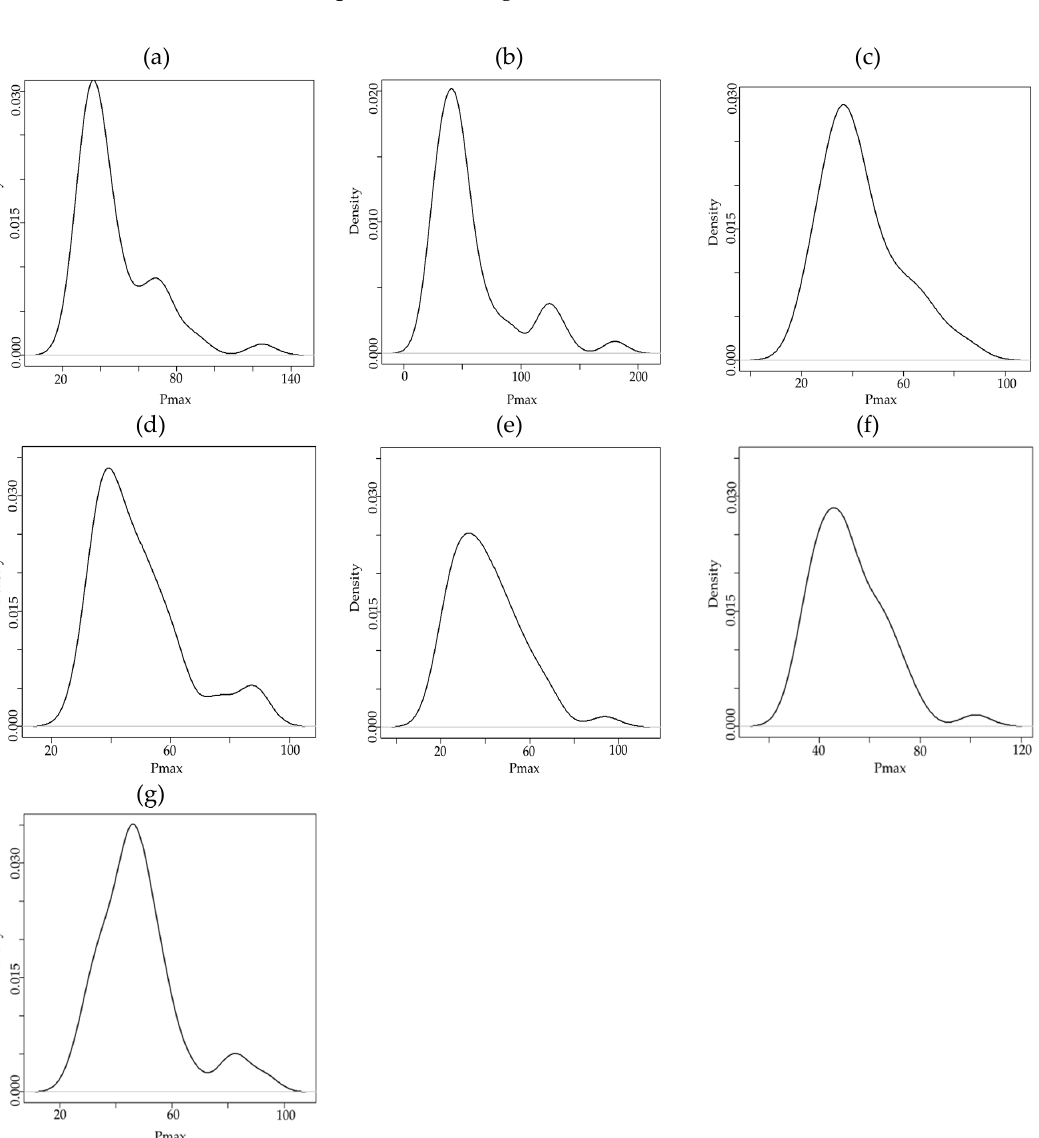
Figure 4. Estimated kernel density function of P max for the rainfall stations in ( a ) Rajcza; ( b ) Radziszów; ( c ) Ksi ąż Wielki; ( d ) Wis ł ok Wielki; ( e ) Radomy ś l Wielki; ( f ) Cisna; ( g ) Koma ń cza.